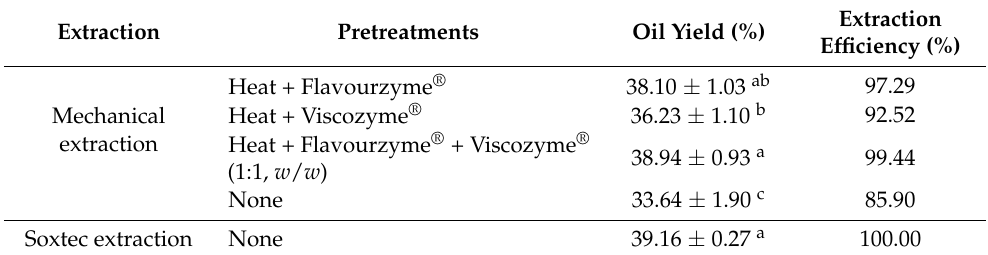
Table 1. Influence of various enzymes on H. heteroclita seed oil extraction.